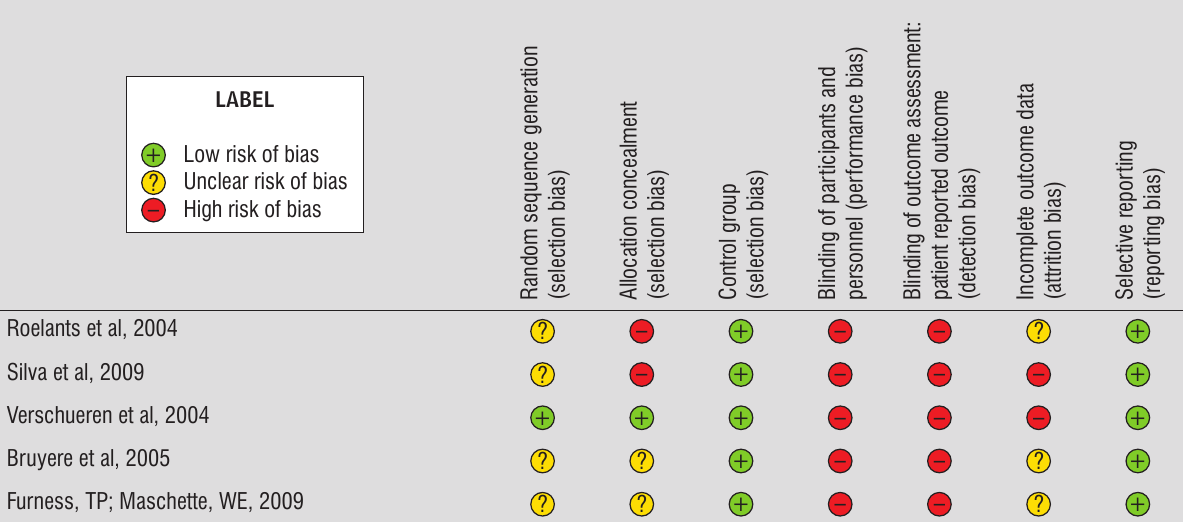
Table 1 - Methodological assessment of studies selected for the strength and quality of life outcomes according to Cochrane Collaboration Reviewer’s Handbook, 5.1.0